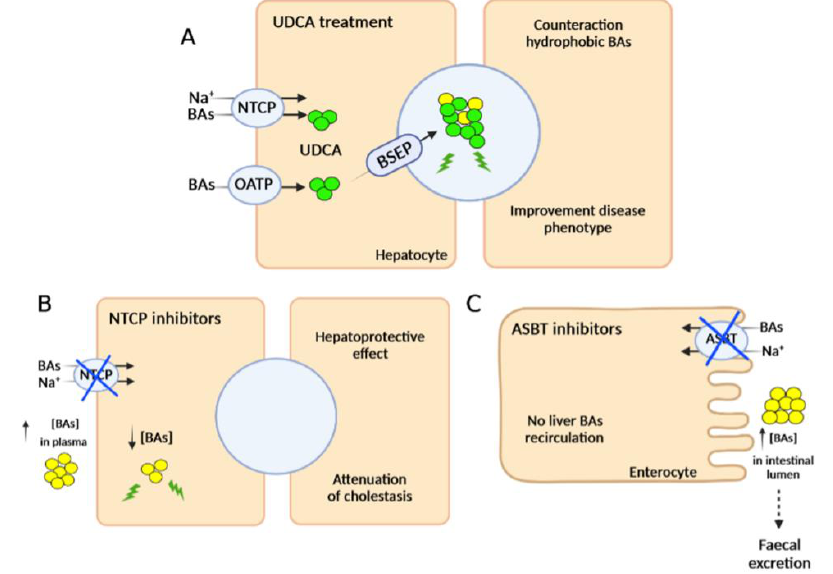
Figure 2. Pharmacological treatments for cholestatic diseases. ( A ) Mechanisms of action of UDCA, which favors the presence of hydrophilic BAs over hydrophobic BAs in bile, decreasing the toxic effect of “detergent bile” in cholestatic patients. ( B ) NTCP transporter inhibitors block the entry of BAs into hepatocytes. ( C ) ASBT inhibitors prevent the reabsorption of BAs in enterocytes, decreasing their entrance into the enterohepatic recirculation. Inhibitions are indicated with blue crosses. BA, bile acid (yellow circles).